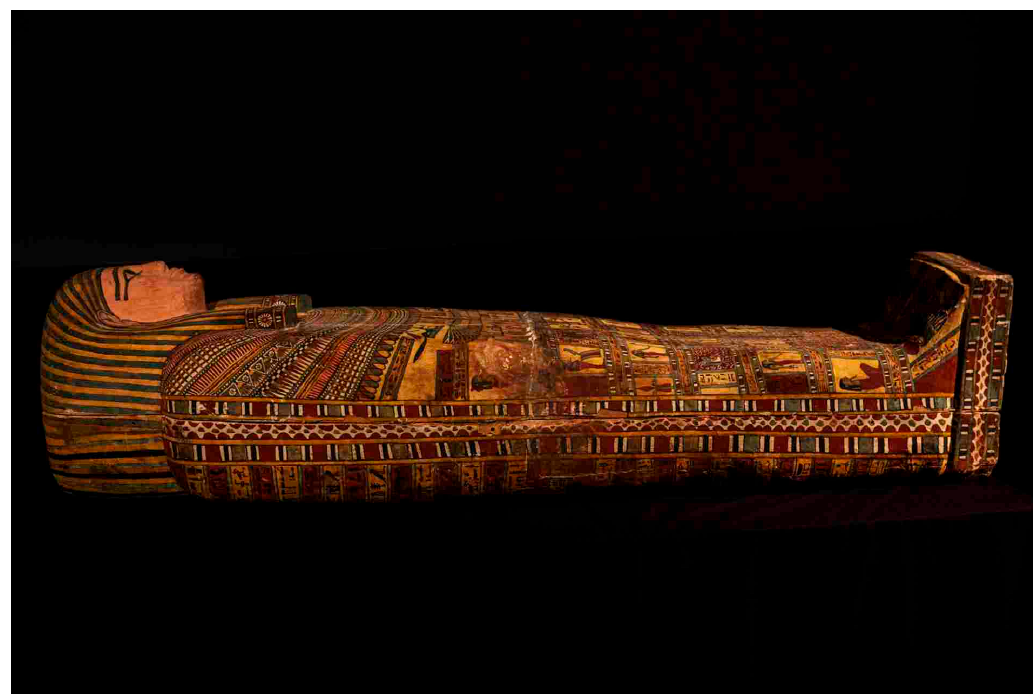
Figure 1. The mummy of the lady Shesep-amun-tayes-herit. Imagery courtesy Rebecca Hale, National Geographic.